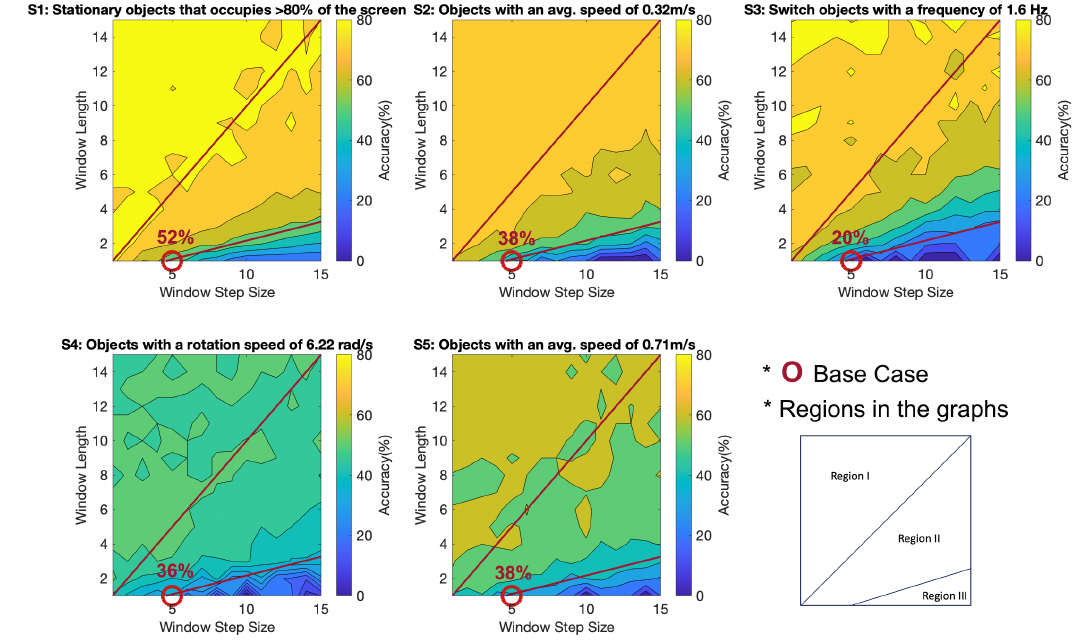
Figure 5. Accuracy of various window filter